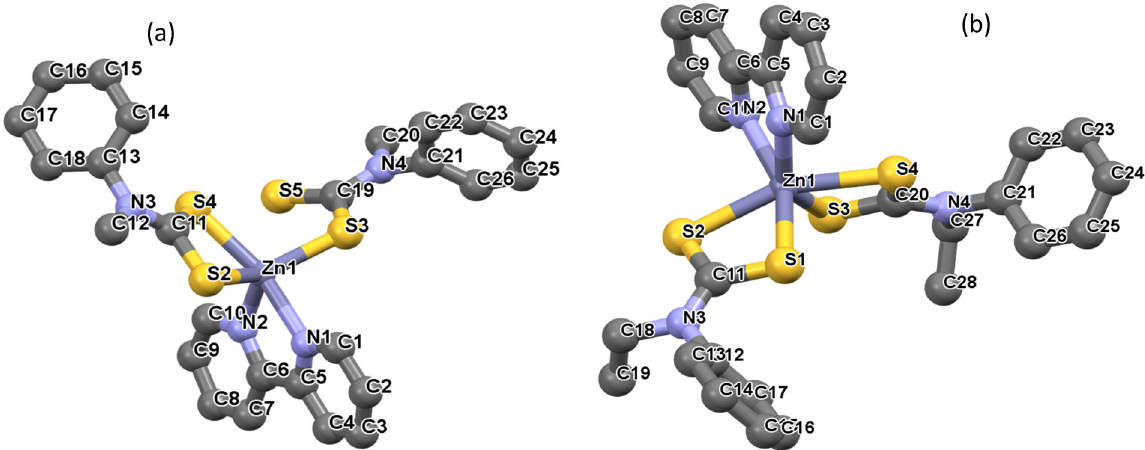
Figure 9: Molecular structure of ( a ) [ Zn ( mpdtc ) 2 bpy ] and ( b ) [ Zn ( epdtc ) 2 bpy ] . Redrawn from ref. [ 15 ] , with permission from Elsevier ( Copyright 2020 )